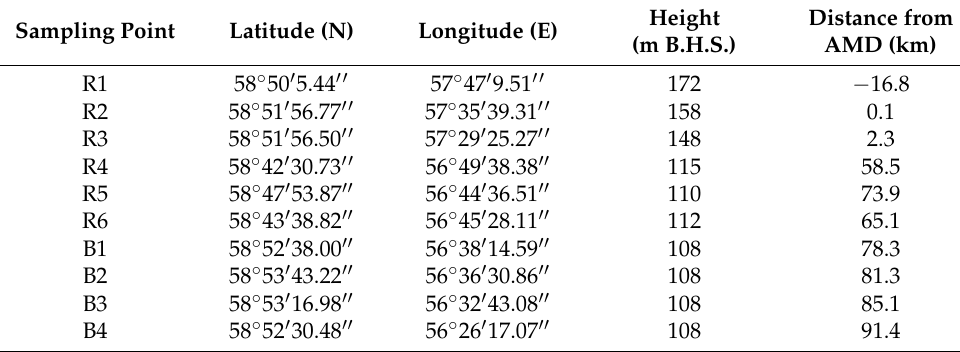
Table 1. Location of sampling